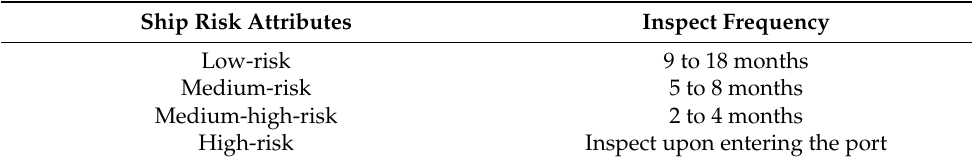
Table 5. Ship risk attributes and inspection frequency